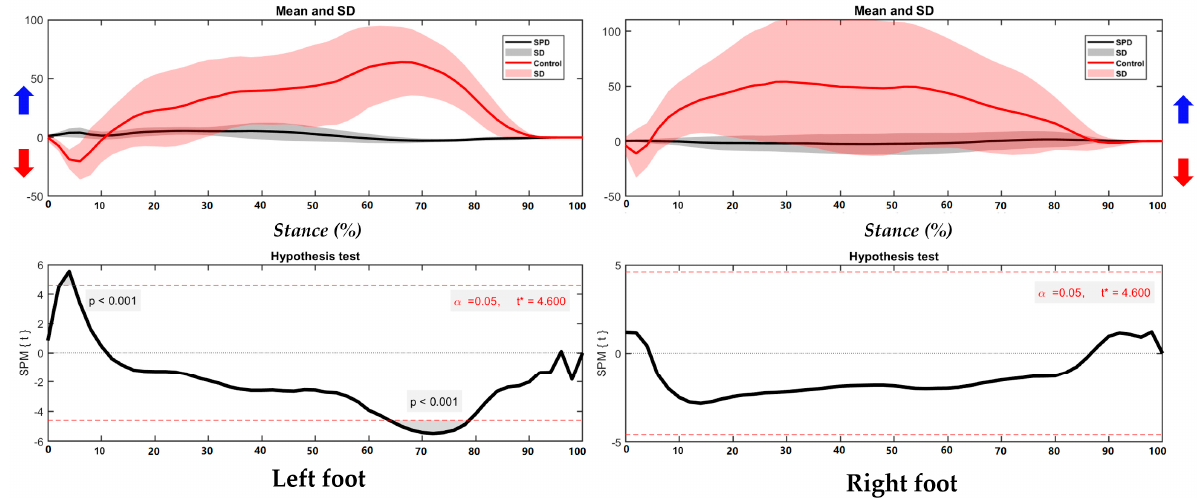
Figure 6. FBI in the left foot and right foot during turning with highlighted direction of pronation (blue arrow) and supination (red arrow).